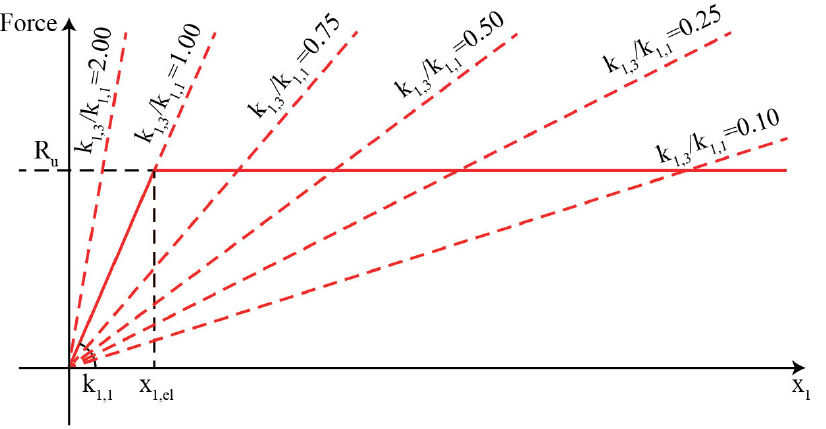
Figure 3. Force–displacement diagram of cladding at multiple membrane stiffness ratios ( k 1,3 / k 1,1 = 0.10, 0.25, 0.50, 0.75, 1.00, 2.00).